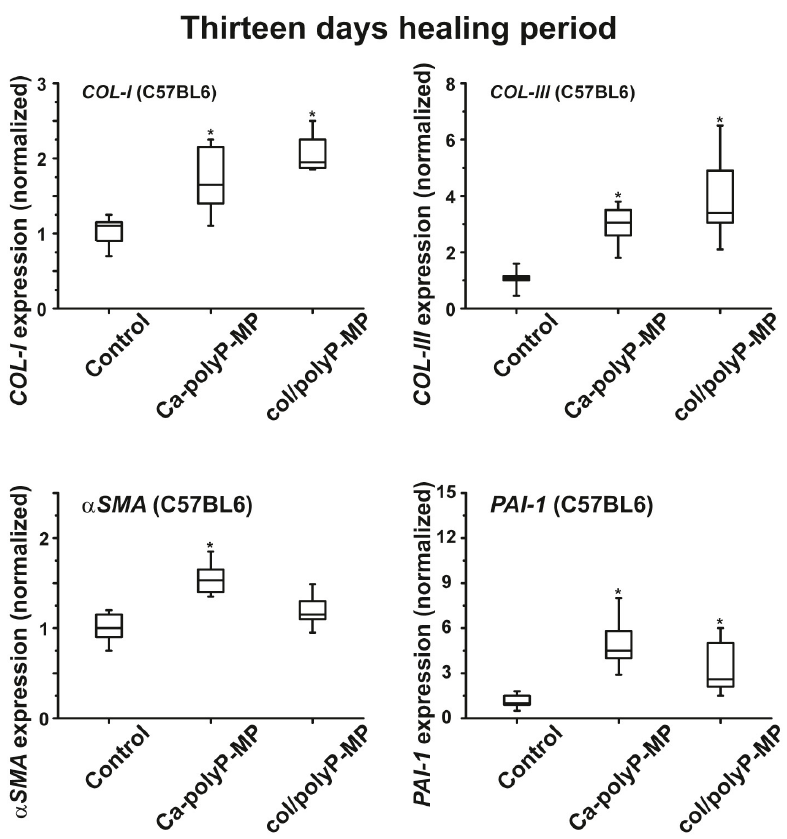
Figure 10. Changes of the steady-state expression of the genes COL-I and COL-III as well as of the genes α - SMA and PAI-1 in wild-type animals after treatment with polyP microparticles. The healing period was 13 days. In all three series of experiments the expression levels of genes in tissue from regenerating wounds that were treated with polyP microparticles (“Ca–polyP-MP” and “col/polyP-MP”) significantly increased compared to control; * p < 0.005 ( n = 6 animals).